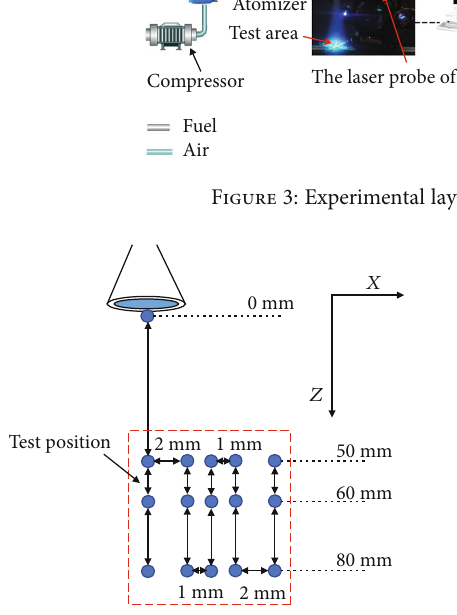
Figure 4: Details of the measurement locations.